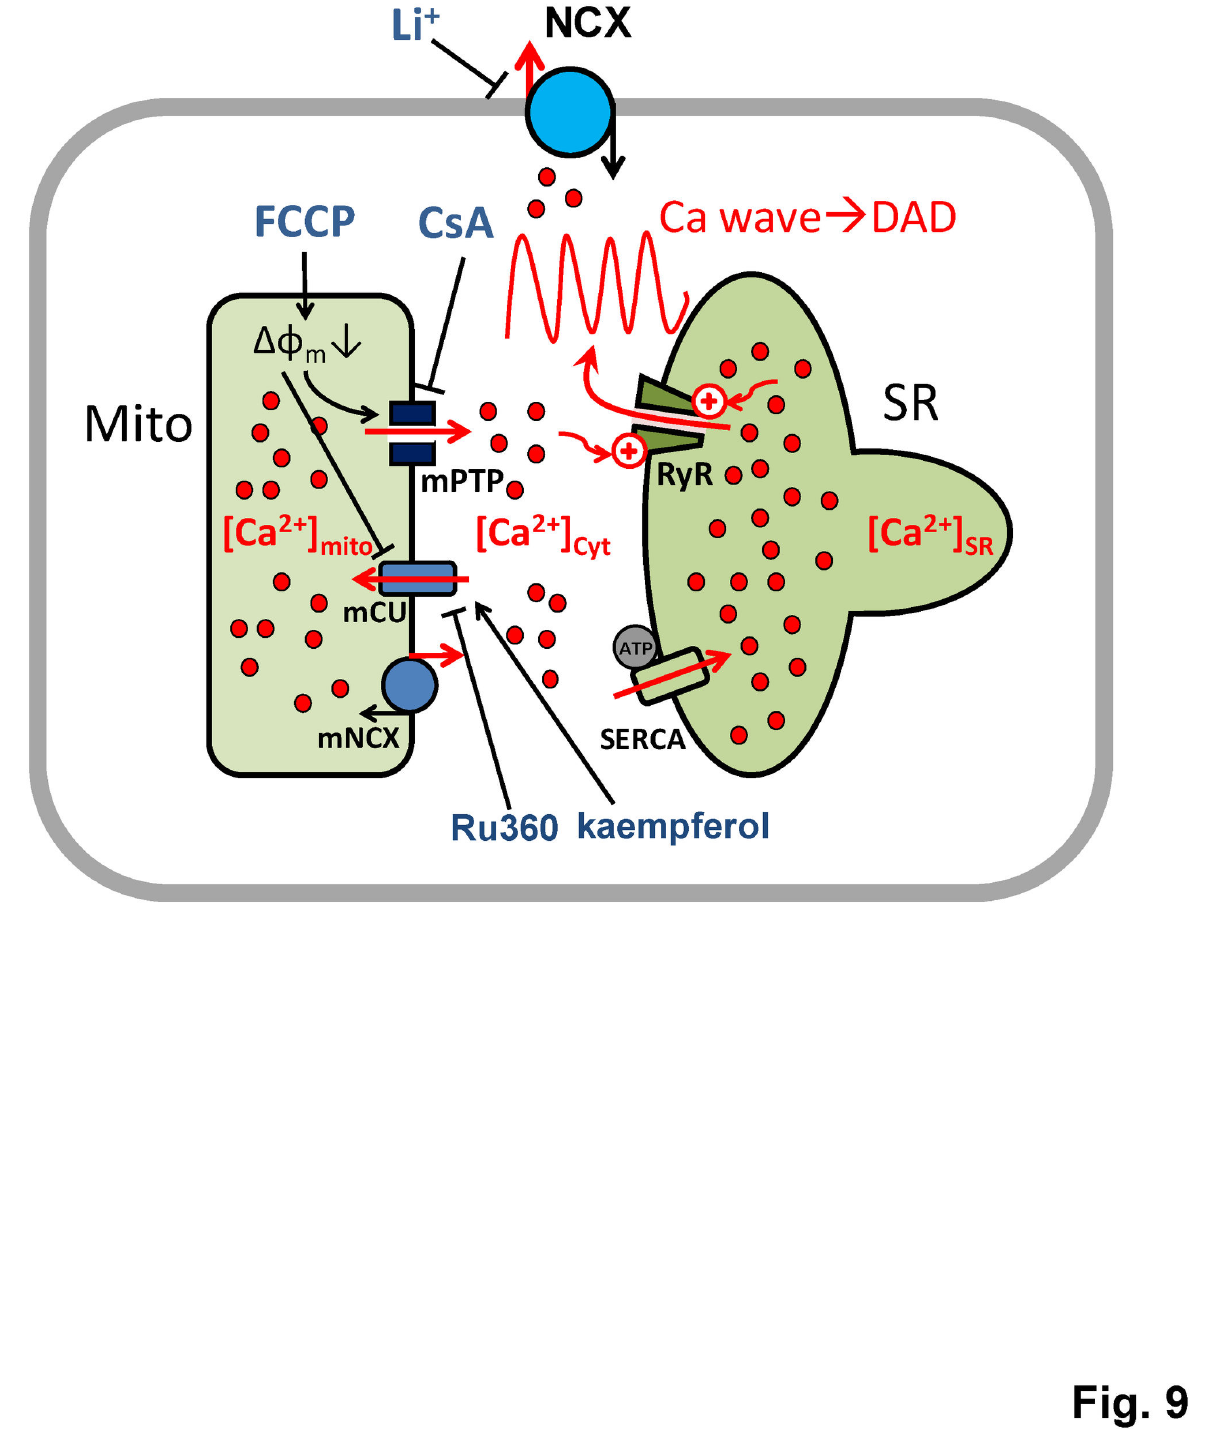
Figure 9. Schematic illustration of Ca 2+ waves modulation by mitochondrial Ca 2+ fluxes. Mitochondrial Ca 2+ is released into the cytoplasm via the permeability transition pore (mPTP) and up-taken by the mitochondrial calcium uniporter (mCU). An increase in local cytosolic [Ca 2+ ] prompts additional uptake of Ca 2+ by the SERCA pump, and triggers a greater release of Ca 2+ by the ryanodine receptor (RyR), thus generating/enhancing CaWs. Either inhibition of mPTP by CsA or activation of mCU by kaempferol suppresses CaWs. doi: 10.1371/journal.pone.0080574.g009 PLOS ONE |